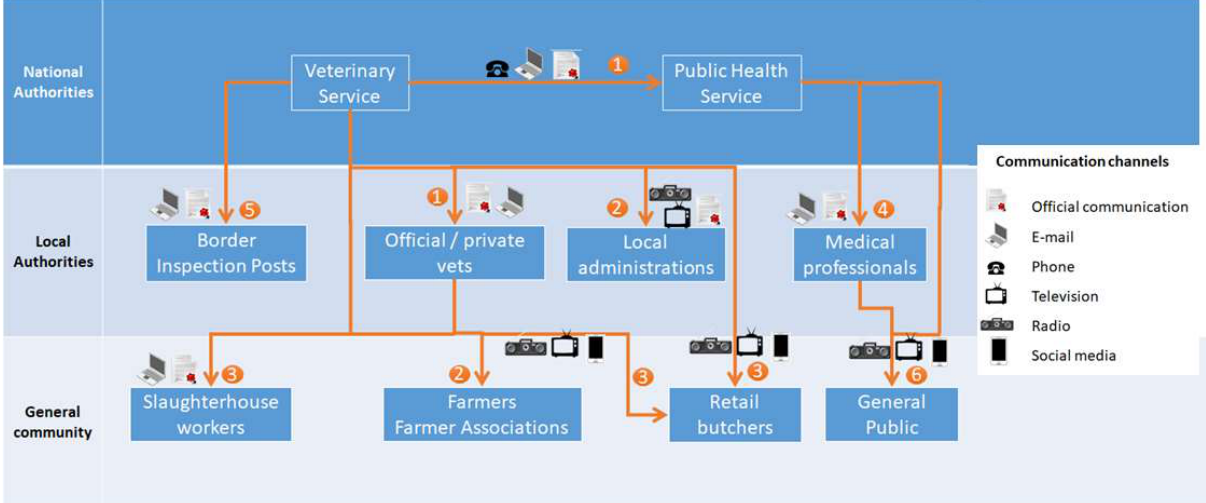
Figure 1. Representation of potential stakeholders and communication channels. The main objec- tives of the messages are (1) To inform about the case definition, and to indicate the type of data that must be collected. (2) To raise awareness, to advise about the correct behaviours on animal management and the prescriptions issued by the veterinary authority, to reinforce the knowledge about biosecurity measures. (3) To advise about the necessity of following good practices (e.g., PPE use, suspects reporting, proper animal manipulation, etc.,) and the need for caution/protective measures when handling potentially affected animal carcasses. (4) To inform about case definition and clinical best practice, to provide indications on contents of communications with patients, and to indicate the type of data that must be collected. (5) To strengthen controls at the borders. (6) To inform about the situation and the actions put in place by the national authorities, to raise awareness about non- official information.